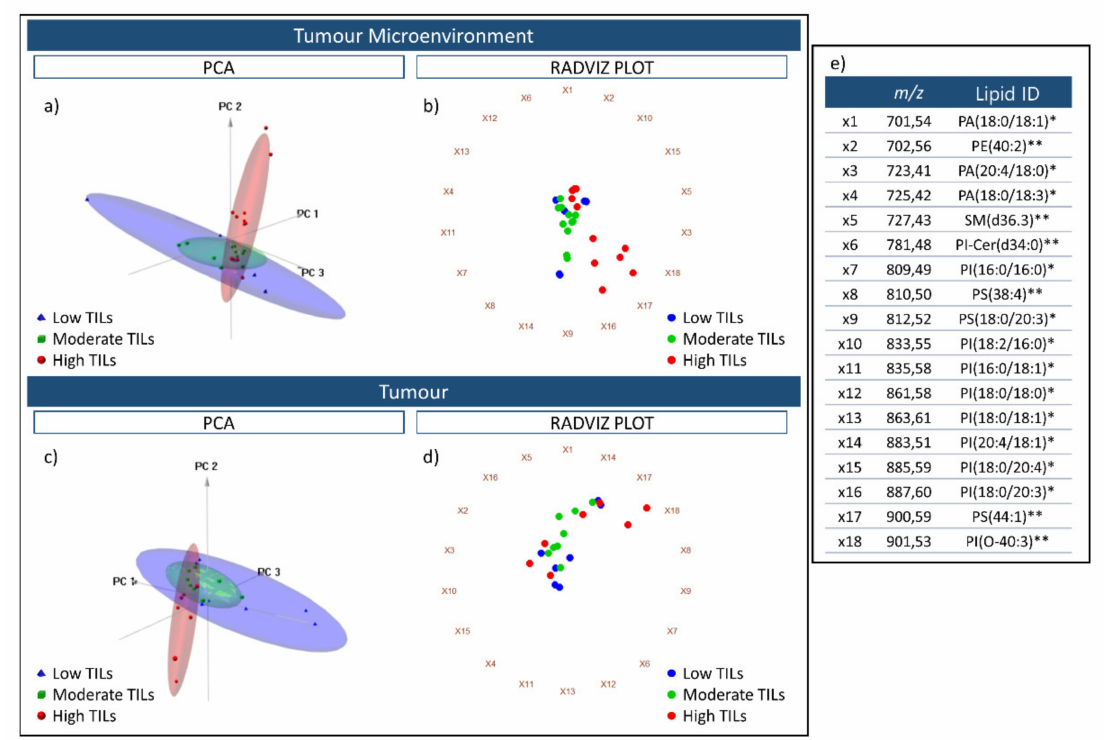
Figure 3. Three-dimensional PCA score charts of the Low TIL (blue), Moderate TIL (Green), and High TIL (red) groups using spectra obtained from the tumour microenvironment ( a ) and tumour ( c ) regions. The first three components explained 93.2% (PC1 74.3%; PC2 11.8%; PC3 6.2%) of the variability within the data. Radviz plots generated using the same spectra from the tumour microenvironment and tumour are presented in ( b , d ). The 18 m / z features that were used for the PCA analysis and Radviz plots are reported in ( e ) and are linked with the identifiers (ie. X1) that are placed around the circumference of the Radviz plot. The putative lipid ID assigned to these m / z features is also provided; * indicates those lipids annotated based on accurate mass, isotopic distribution and MS/MS whilst ** indicates those lipids annotated based on accurate mass and isotopic